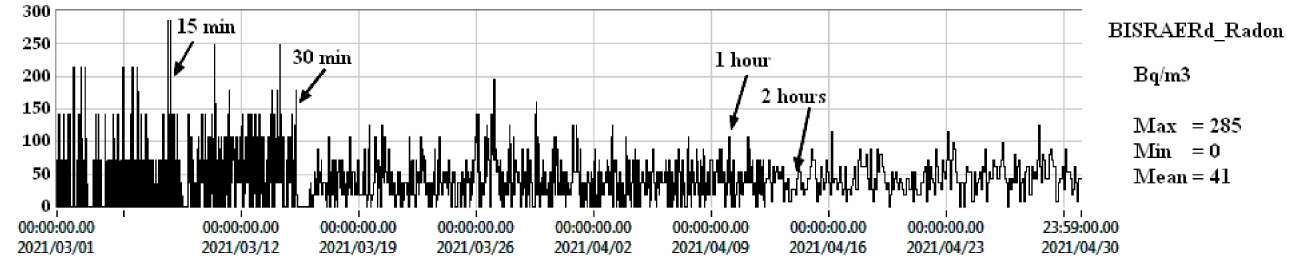
Figure 6. Testing of sampling rates for AER + C, station Bisoca (format of 2021/03/01 is yyyy/mm/dd).